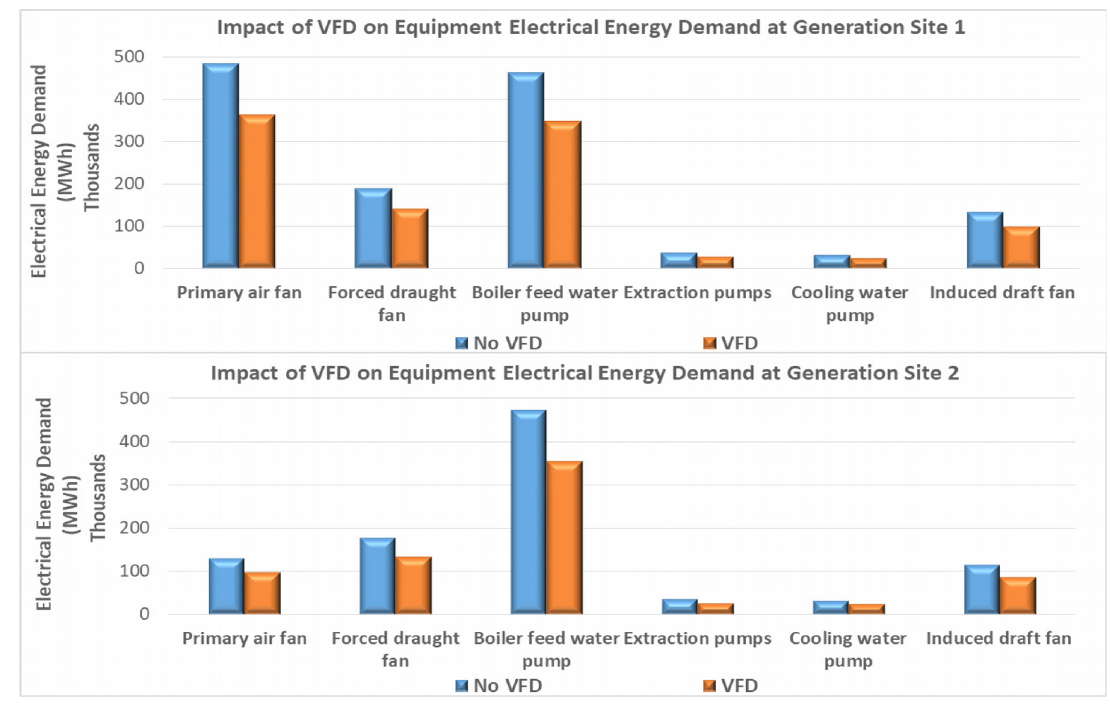
Figure 12. Impact of VFD on individual process equipment energy